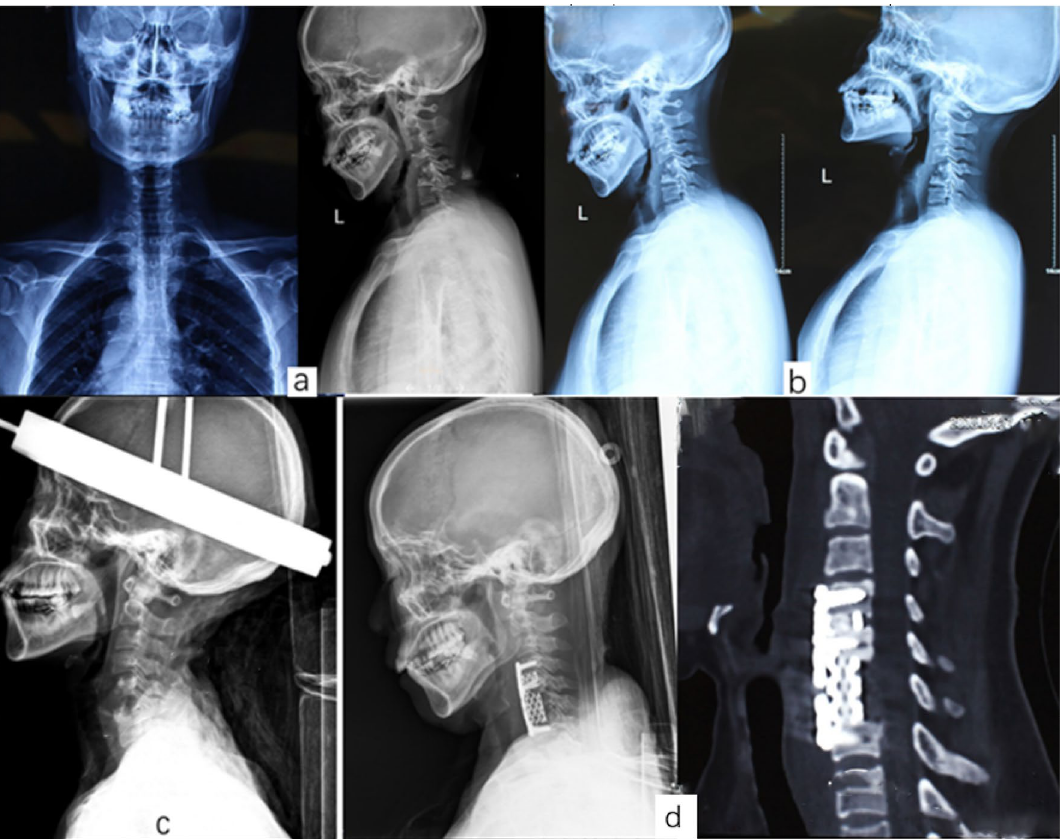
Figure 3. A 63 years old female with C5–6 TB infection with refractory kyphosis who underwent preoperative skull traction ( a ) preoperative AP and lateral X-ray films, ( b ) dynamic X-ray showing no obvious change in kyphosis in both flexion and extension, ( c ) after 8 days of halo-traction the cervical lordosis was recovered, ( d ) postoperative X-ray and CT-scan at final follow-up showing good bone fusion and lordosis